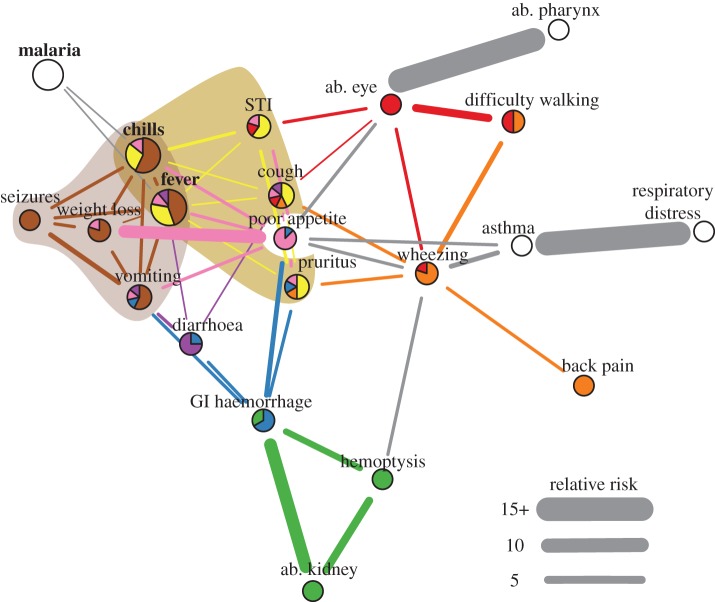
Full population comorbidity. Nodes represent reported symptoms/diseases; HPO terms are shown for symptoms. Abbreviations: ab. ‘abnormality of the’, GI ‘gastrointestinal’ and STI ‘sexually transmitted infection’. Edges shown had relative risk (RR) > 1, ϕ > 0 and q-value < 0.05. Widths of edges are capped at a RR of 15. Colours correspond to link clusters; grey edges and white nodes were not grouped into a link cluster. The main clusters for fever are shaded as a visual aid. A main cluster was where a majority of edges for fever were grouped. If there was no majority, all clusters with greater than 1 edge with fever were highlighted/shaded. Bolded and enlarged nodes were the symptoms/diseases that were most often co-reported with another symptom/disease. Among individuals who reported at least two symptoms/diseases (8718), malaria, fever and chills were mentioned by 70.19% (6119), 45.94% (4005) and 37.46% (3266) of people, respectively. A force-directed layout for comorbidity networks was used; the most connected symptoms/diseases are shown in the centre of the graphs.